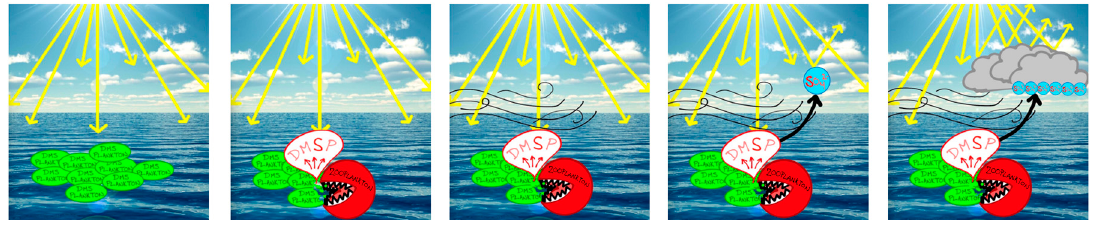
Figure 1. Selected images used on the website to illustrate aspects of the DMS cloud-albedo feedback.